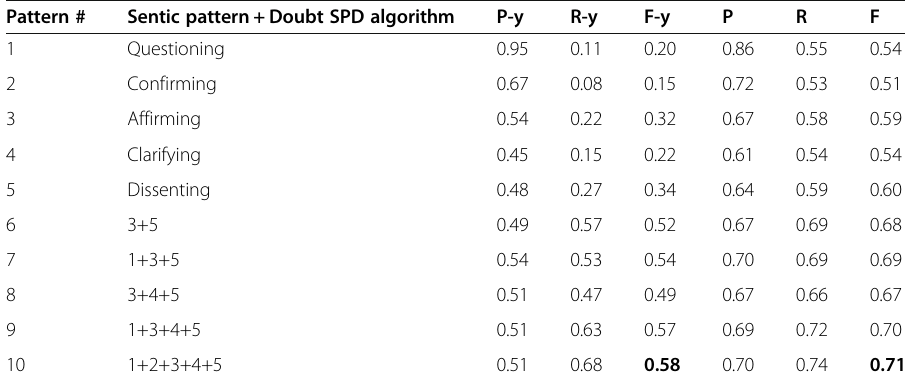
Table 6 Results of various sentic patterns with performance metrics for both identifying doubt and overall doubt classification ( P, R, F denotes Precision, Recall, and F1 score, respectively with P-y indicating Precision in identifying doubt or label ‘ y ’ during testing ) Pattern # Sentic pattern + Doubt SPD algorithm